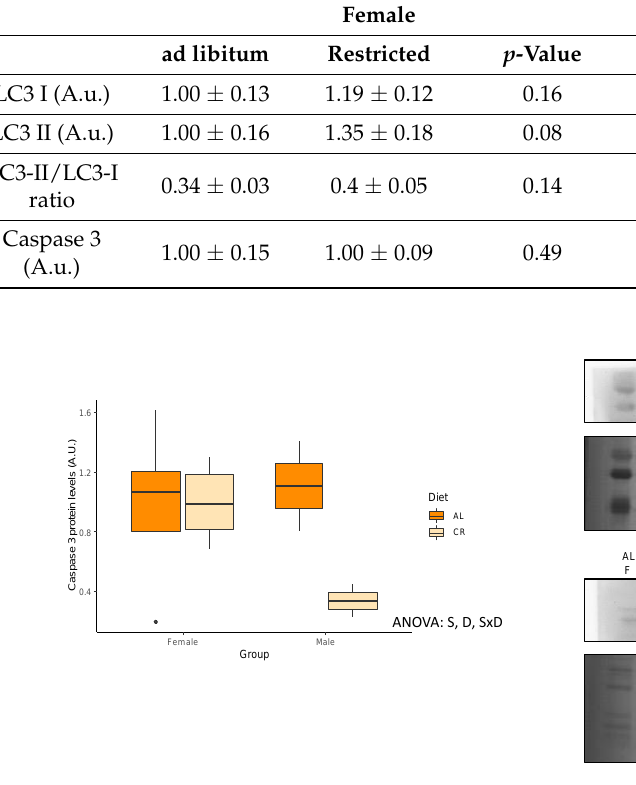
Figure 5. Protein levels of caspase 3. Boxplot showing the protein levels of Caspase 3 and representative bands of the Western blot. Two-way ANOVA was performed to assess for significance. Abbreviations: S, sex differences; D, diet differences; SxD indicates interactive effect between sex and diet; AL: ad libitum; CR: caloric restriction; F: female; M: male.